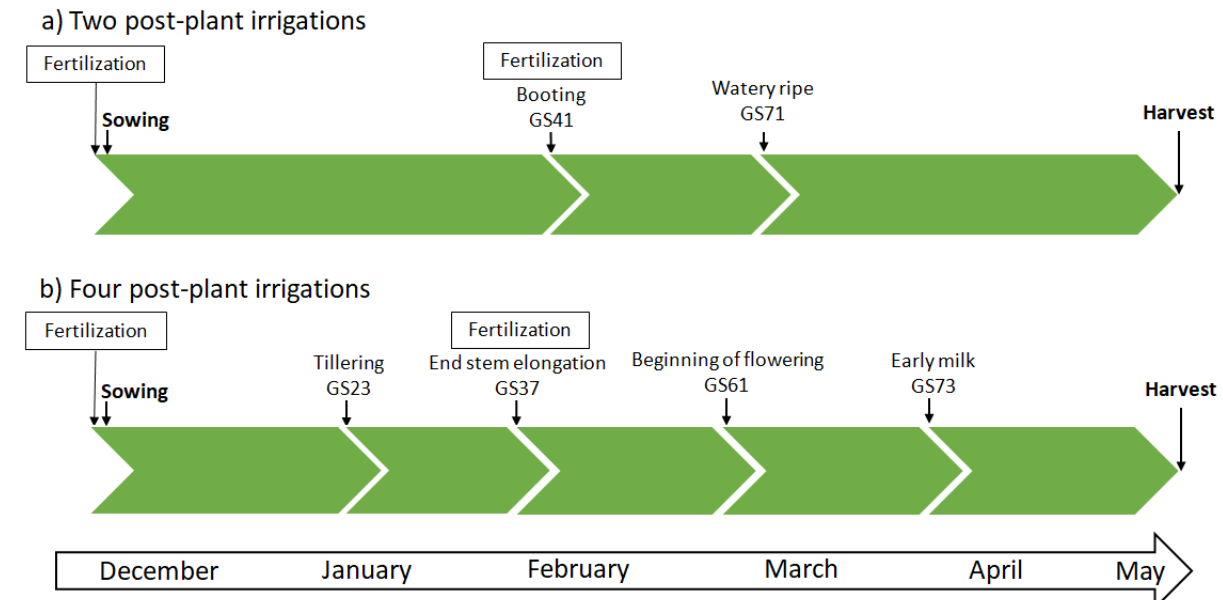
Figure 2. Schematic timeline of the treatment applications for the two post-plant irrigations ( a ), and the four post-plant irrigation blocks ( b ). Post-plant irrigations applied in the separation between indicated growth stages (GS). Fertilization refers to N application as urea, either at pre-sowing (first application) or a as a topdressing (second application).